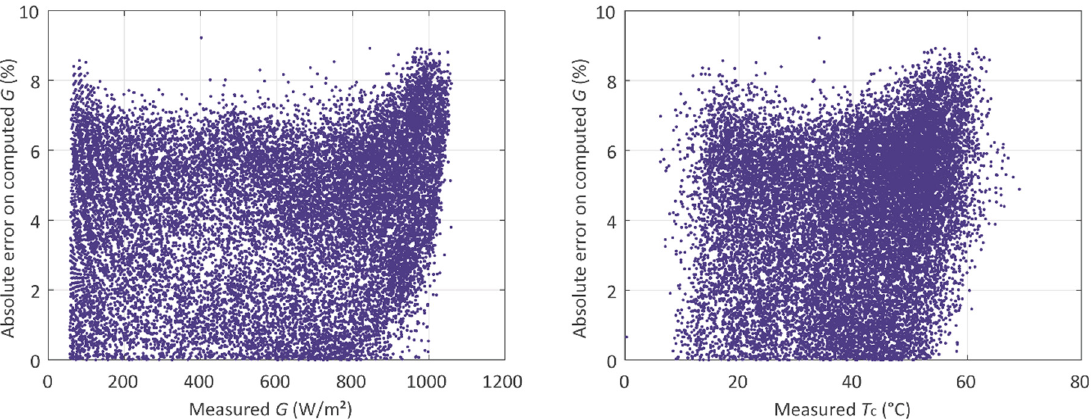
Figure 4. Absolute errors on computed solar irradiance G (from I mpp ) and corresponding measured values of G and T c.